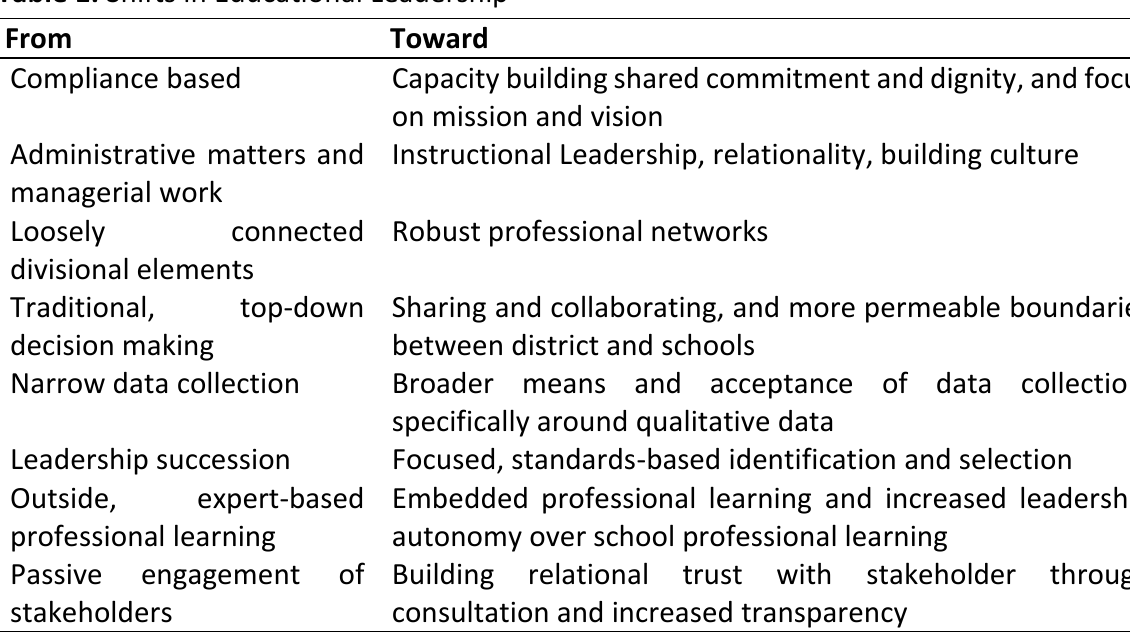
Table 1. Shifts in Educational Leadership